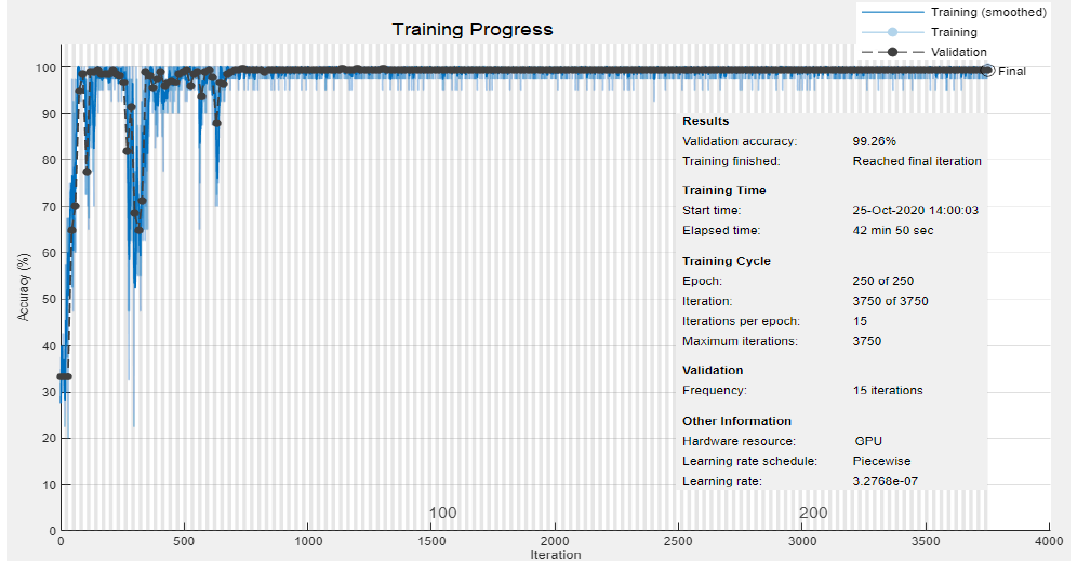
Figure 12. Experiment 3 Intra-patient scheme using DS3.1: Training and validation accuracy progress for three classes: Normal, ST-change, and